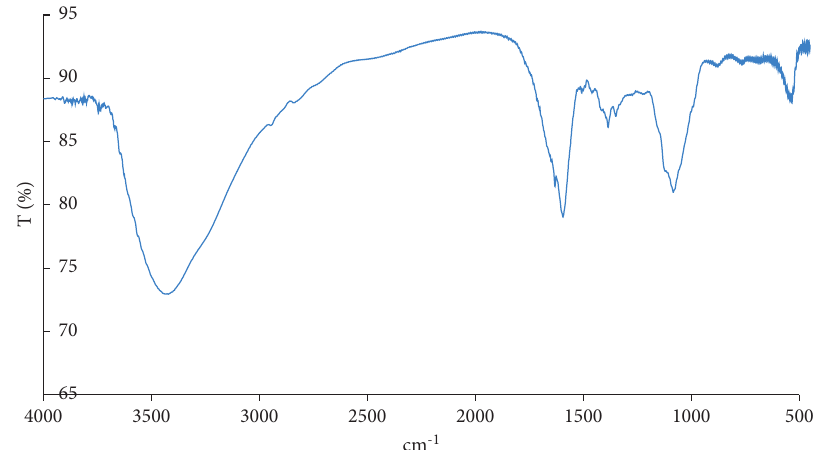
Figure 1: Infrared spectrum determination curve of Inonotus obliquus oligosaccharide IOP-2A.